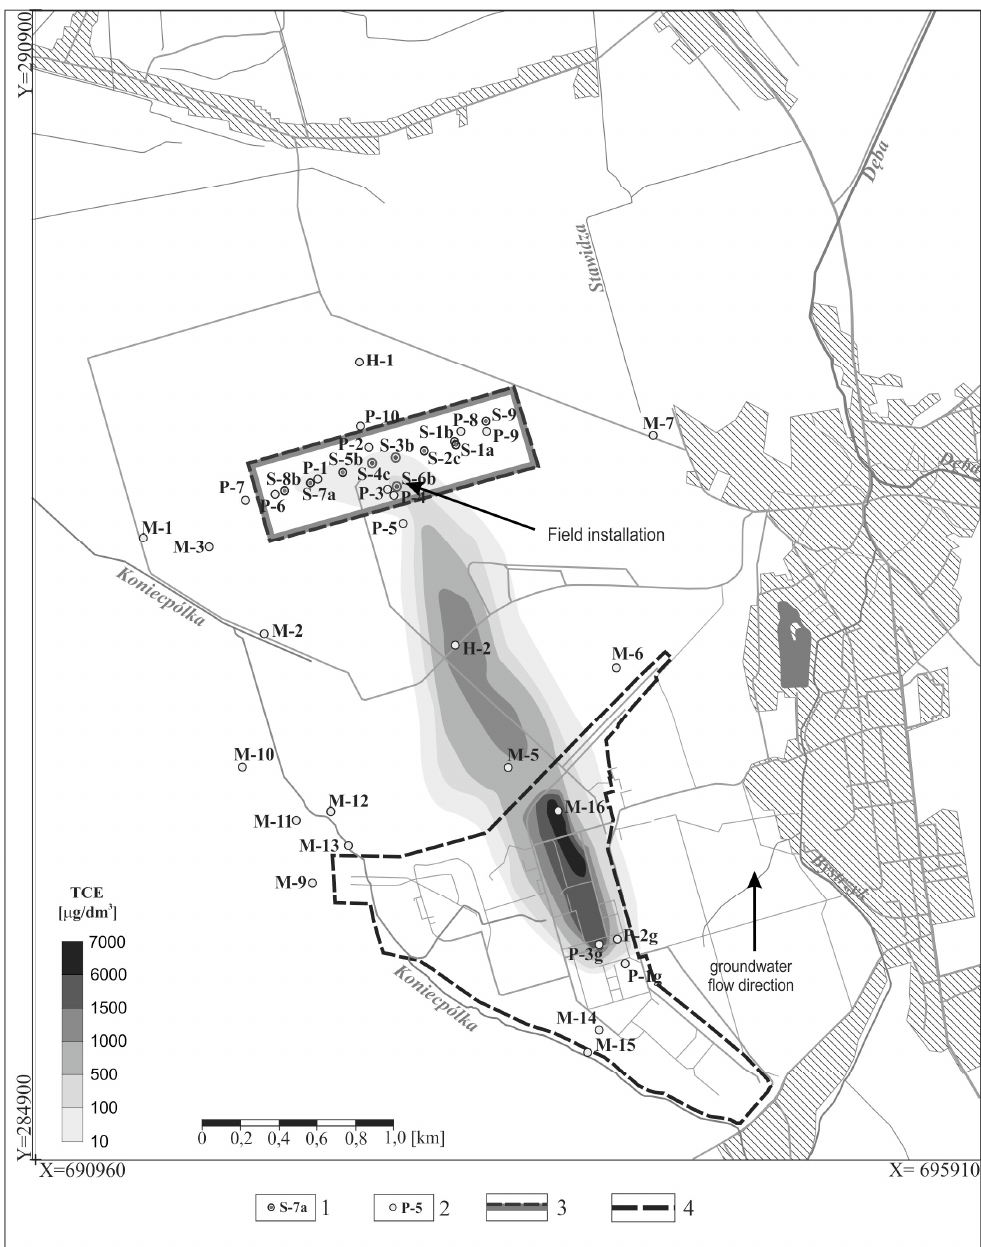
Figure 1. Overview map of the contaminated site including the location of metal-works factory, the affected waterworks and the estimated extent of the contaminant plume. Notation: 1—extraction wells; 2—piezometers; 3—waterworks area; 4—metal-works area.